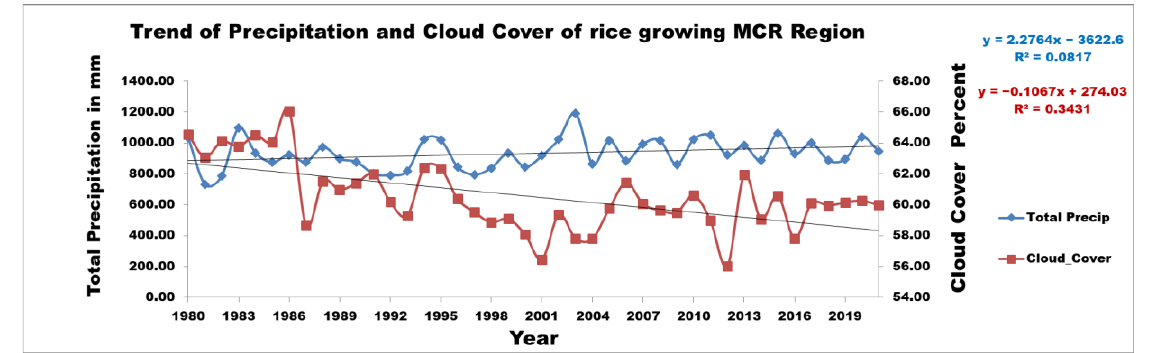
Figure 4. Trend of Precipitation and Cloud Cover for MCR region.